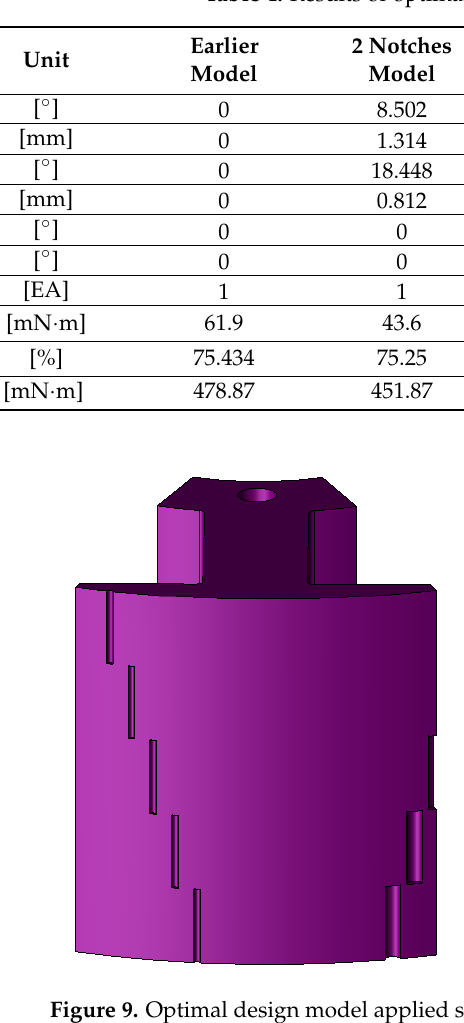
( d ) Figure 10. Optimal design results ( a ) cogging torque ( b ) FFT of cogging torque ( c ) torque ( d ) voltage.